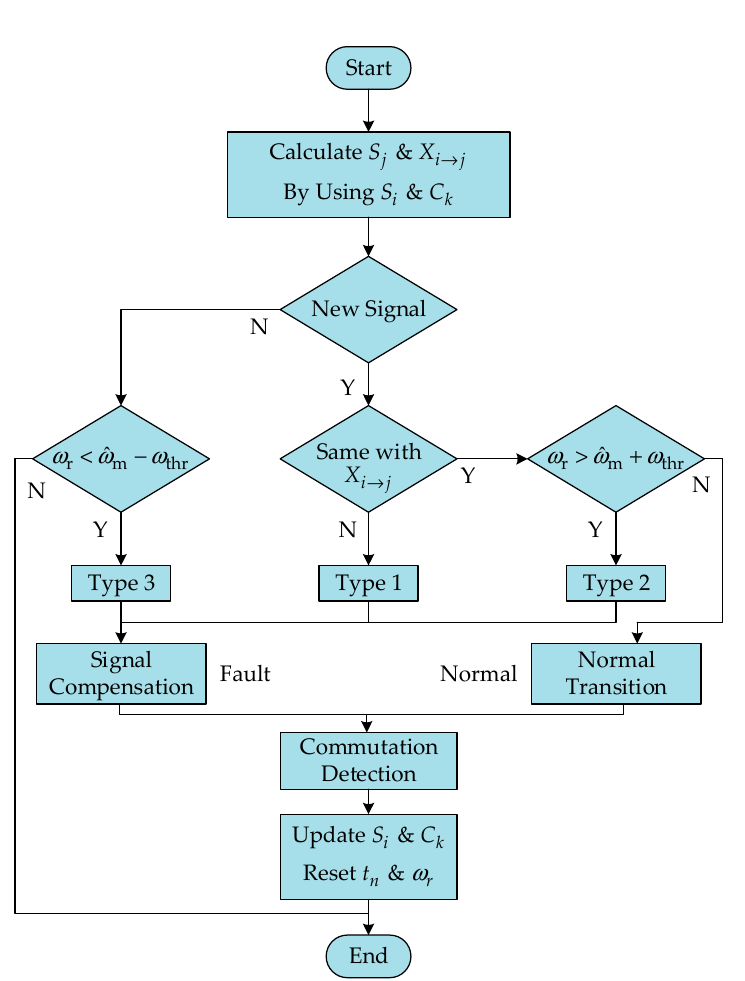
Figure 9. Fault diagnosis logic based on FSM-STA.